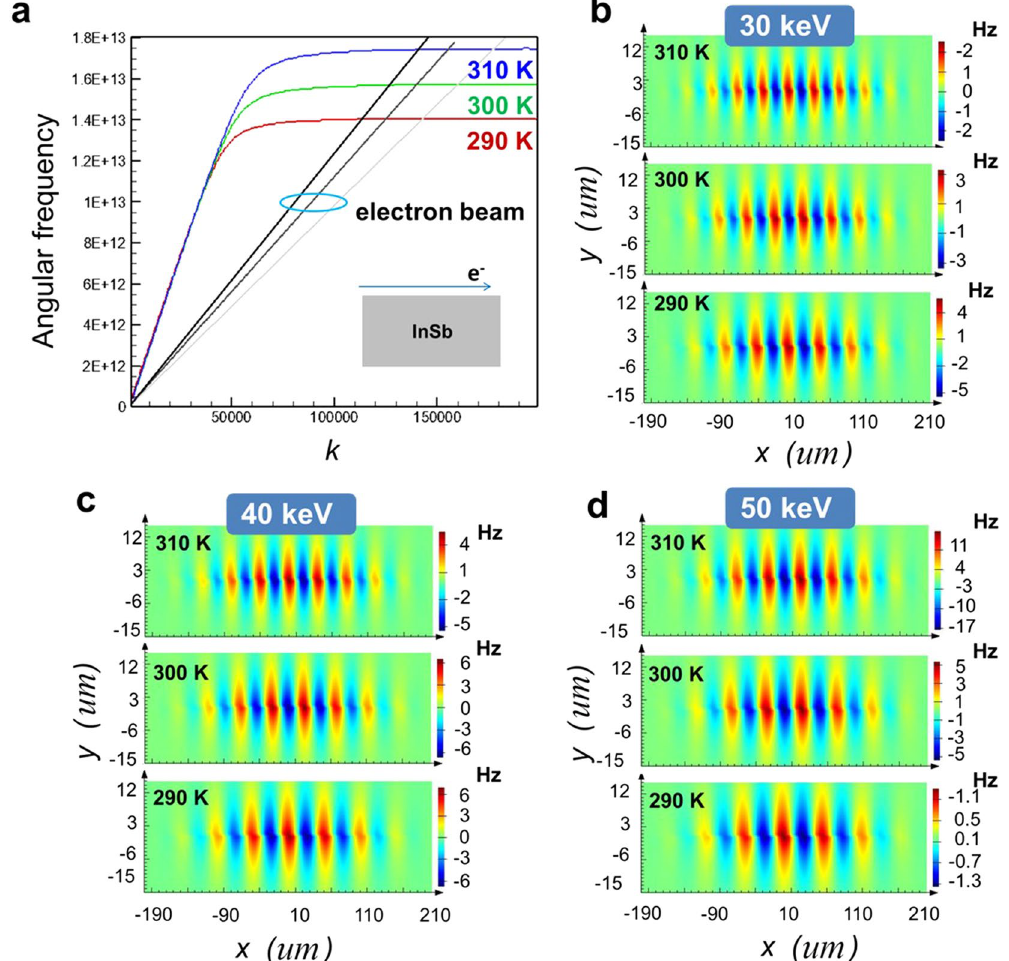
Figure 2. Dispersion curves and excited SPs at the air-InSb interface. ( a ) Blue (green, red) line: Dispersion curve of SP at the air-InSb interface with T = 310 K (300 K, 290 K). Black line (dark grey, light gray): Dispersion curve of electron bunch with E = 50 keV (40 keV, 30 keV). ( b ), ( c ), and ( d ) Simulated Hz field contours of SPs excited by electron bunch passing over the InSb substrate under various temperatures (i.e., 290 K, 300 K, and 310 K) with E = 30 keV, 40 keV, and 50 keV,